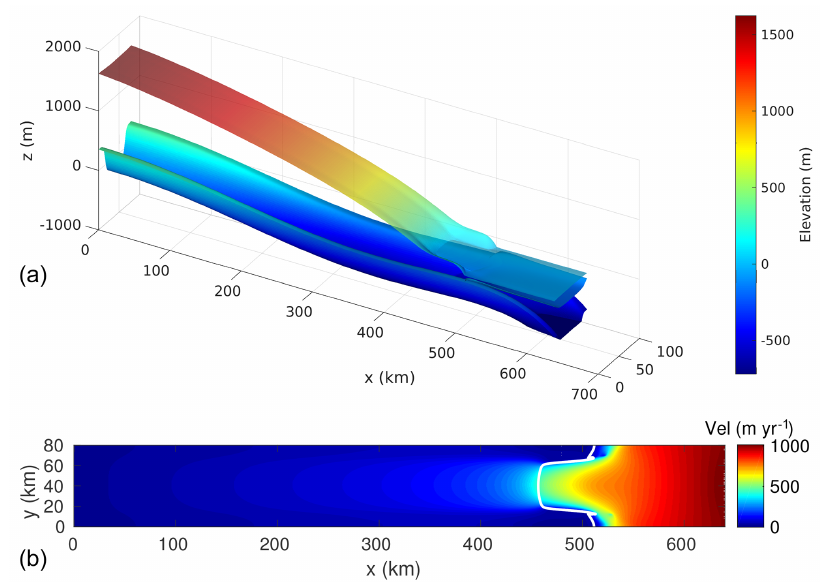
Figure 1. Model domain and initial steady-state geometry for the 125m resolution mesh with a Weertman sliding law. (a) Bedrock elevation and initial steady-state ice surface and basal elevation (Note the vertical exaggeration). (b) Initial steady-state velocity (in myr − 1 ). The white line shows the initial grounding line